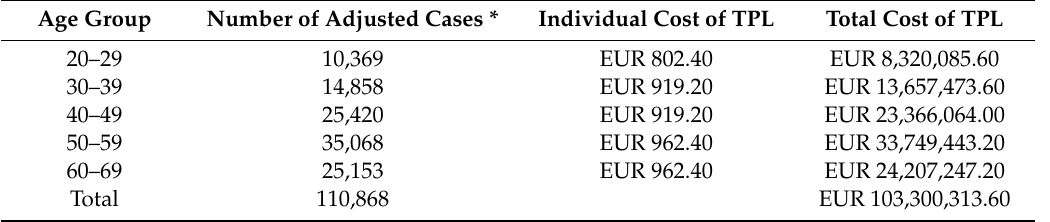
Table 2. Estimated temporary productivity loss per age groups calculated with the Human Capital Approach (HCA) (2020 euros).